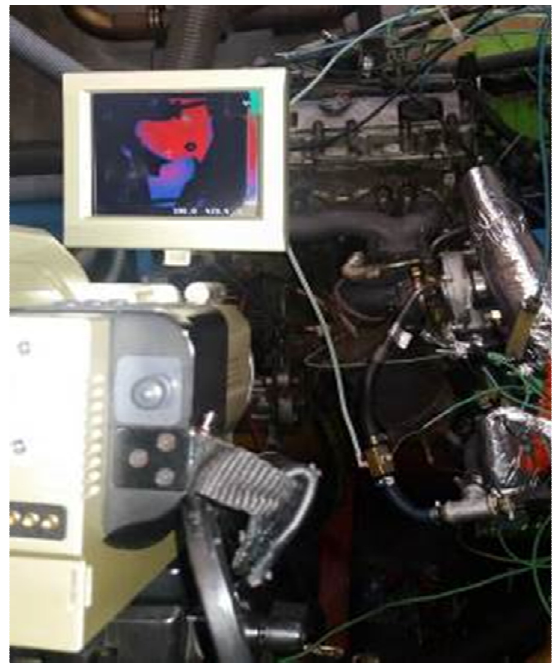
Figure 7. Engine test cell overview.